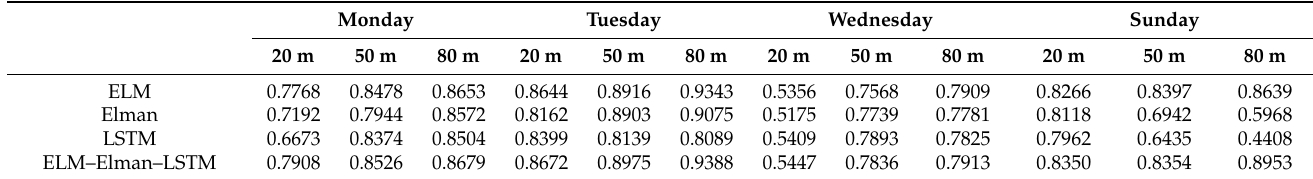
Table 6. R-squared of the ELM–Elman–LSTM model and the three single